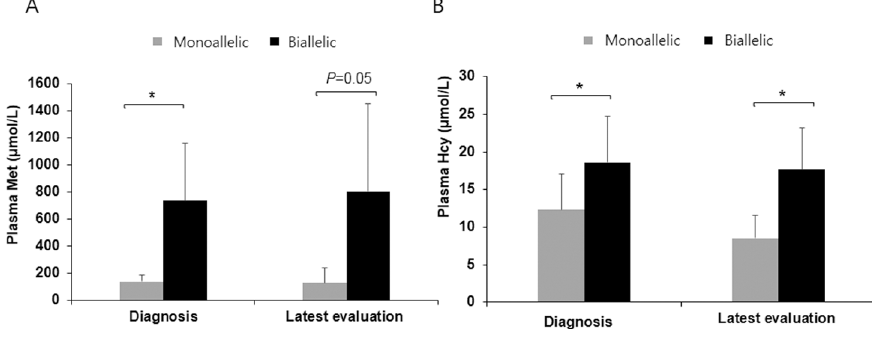
Figure 1. Comparison of plasma methionine and homocysteine levels between the auto- somal dominant (AD) form and the autosomal recessive (AR) form in MAT I/III deficiency. (A) The mean of plasma methionine levels at diagnosis and the latest evaluation of the AR form was higher than that of the AD form ( P = 0.02, 0.05). (B) The mean of initial and latest homocysteine levels of AR form was higher than that of the AD form ( P = 0.04, 0.02). Data represent the mean ± standard deviation. * P <